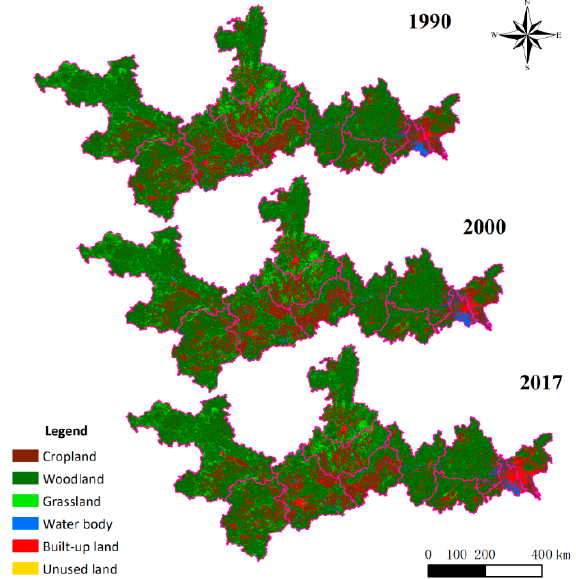
Figure 2. Land use maps in 1990, 2000, and 2017. Table 1. The land-use classification system.